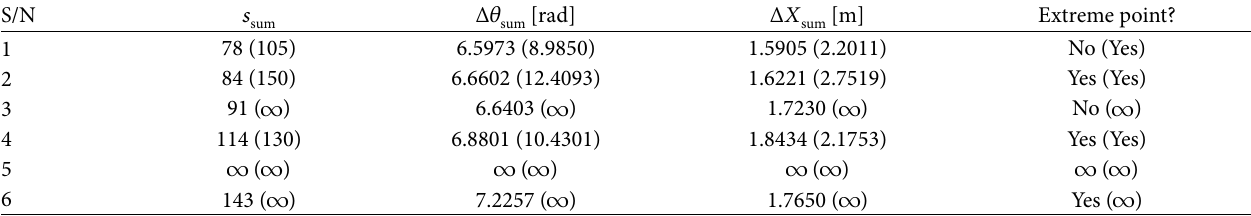
Table 7: Comparison of data between two planning methods for three or more